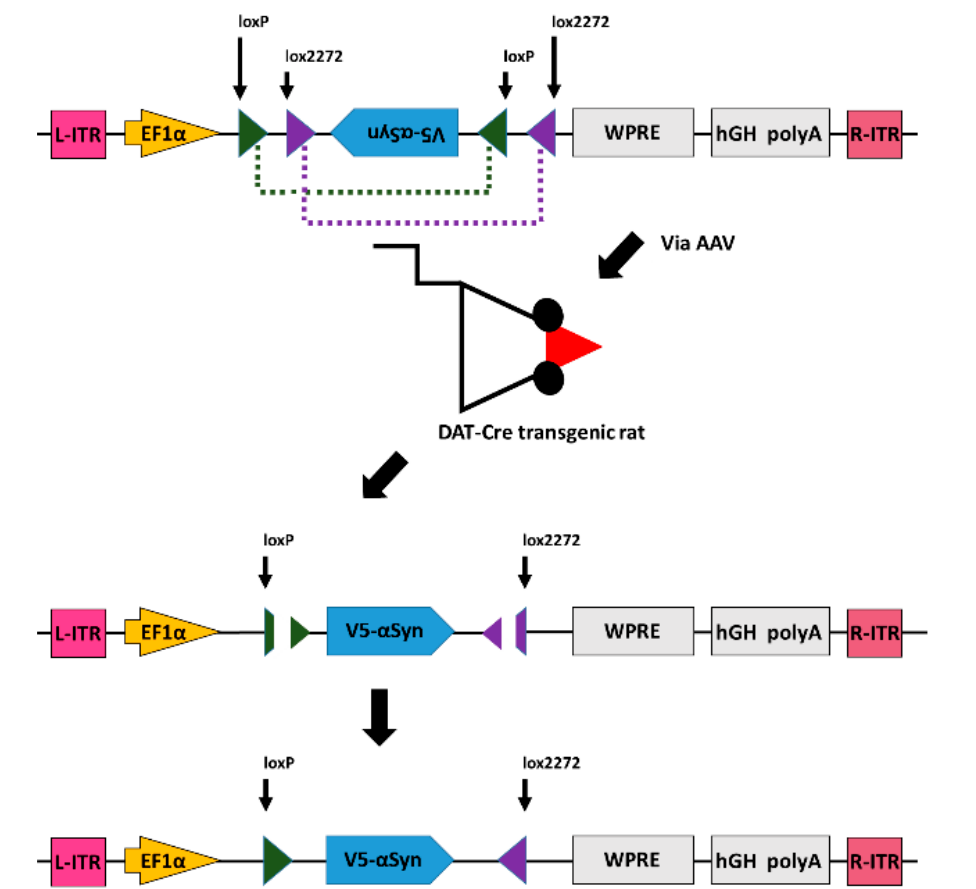
Figure 1. Expression of α -synuclein in dopaminergic neurons through Cre-DIO system. AAV containing the double floxed inverted open reading frame (DIO) of the α -synuclein ( α Syn) construct, tagged with a V5 epitope at the N-terminal, was administered to the nigra of DAT-Cre rats, which constitutively express Cre recombinases driven by the promoter of dopamine transport (DAT) in dopaminergic neurons. DAT-specific Cre recombinase reverses the gene orientation of V5- α Syn in dopaminergic neurons via action on the lox2272 and loxP. Selective expression of V5-tagged α Syn can, thus, be established in nigral dopaminergic neurons of DAT-Cre transgenic rats. ITR, inverted terminal repeats; hGH poly A, human growth hormone polyadenylation signal; WPRE, woodchuck hepatitis virus post-transcriptional regulatory element.